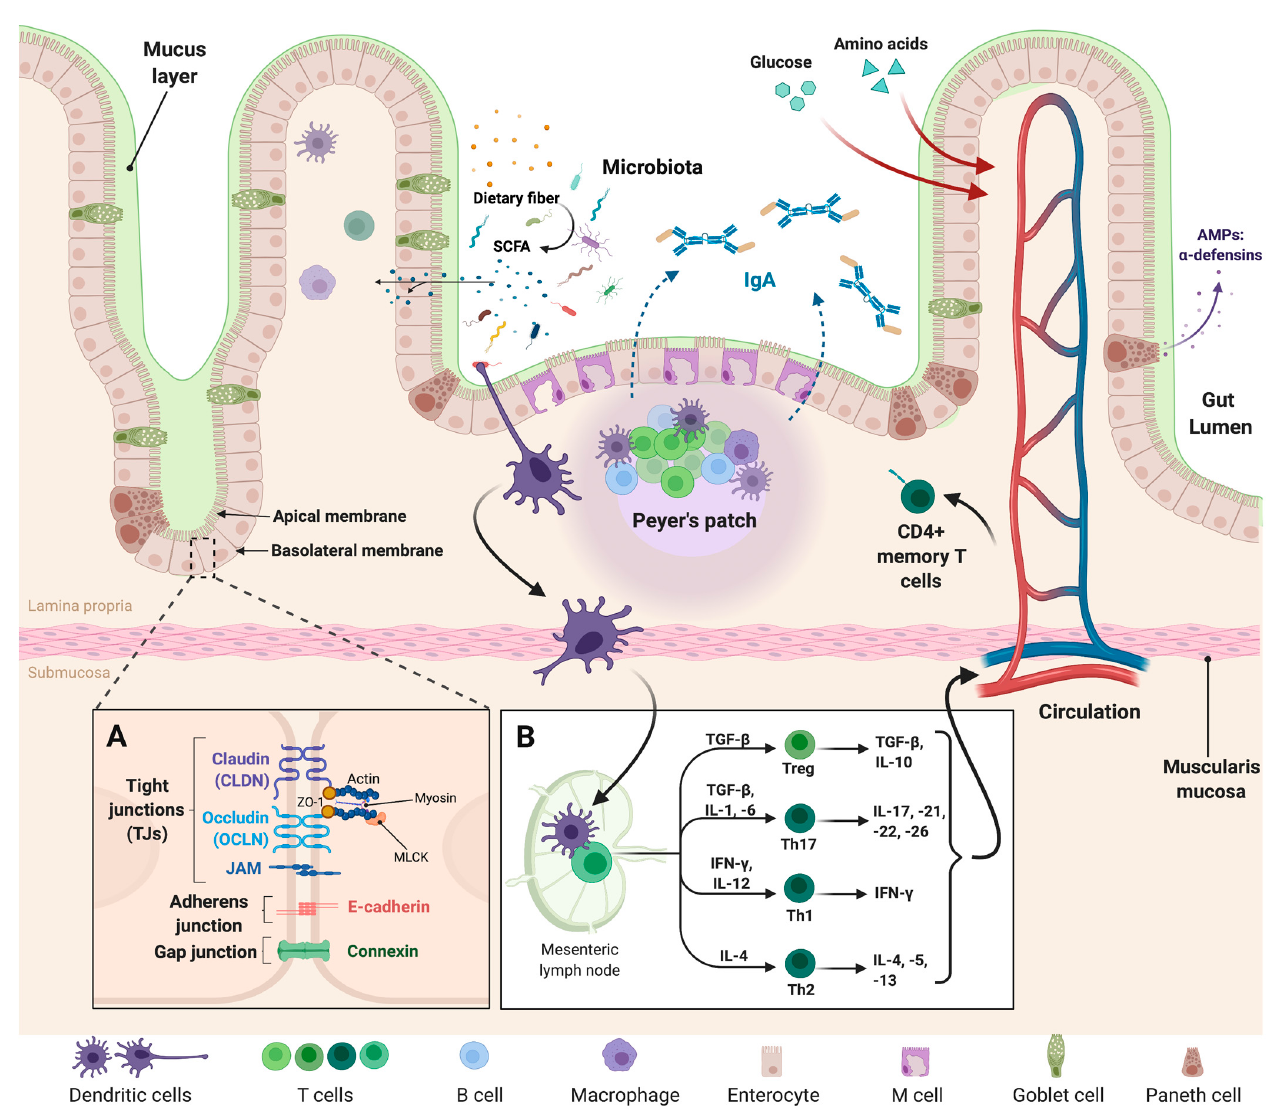
Figure 1. Intestinal epithelial barrier organization. The intestinal epithelium is composed of enterocytes, enteroendocrine cells, M cells, Goblet cells, and Paneth cells. ( A ) Structure and composition of the junctional protein complex: the junctional protein complex consists mainly of tight, adherens and gap junctions; they seal the intracellular space and regulate paracellular permeability. ( B ) The GIT is also closely related to the local immune system: the immune response is induced through the expression of TLRs on macrophages, dendritic cells, and T- and B-lymphocytes. This response increases the production of secretory immunoglobulin A (IgA) associated with the action of M-cells to B-lymphocytes. This IgA is able to distinguish between commensal and pathogenic bacteria and thus maintain the balance and regulation of intestinal homeostasis. Diets containing fermentable fibers and resistant starches result in an increase in intestinal fermentation (by bacteria present in gut microbiota, mainly), and therefore to an increase in the production of short-chain fatty acids (SCFAs), such as acetate, butyrate, and propionate. On the other hand, glucose and amino acid molecules issued from diet diffuse from the small intestine lumen into blood capillaries. (This figure was created with Biorender.com, access date: 24 May 2021).